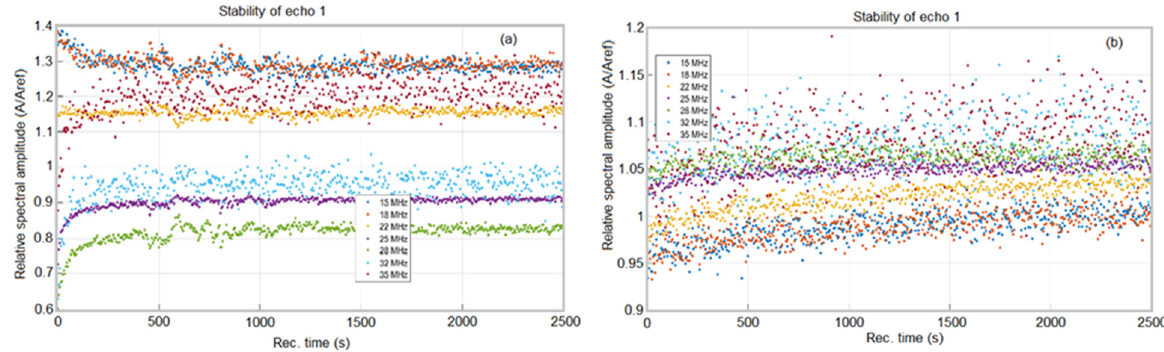
Figure 10. Relative spectral amplitudes versus time for polluted ( a ) and depolluted ( b ) water. Relative amplitudes around 1 indicate a very low concentration of soluble sub- stances. At very high frequencies, the dispersion of the results is +/ − 40%, but around the central frequency (25 MHz), the results are clear. In the case of the contaminated water